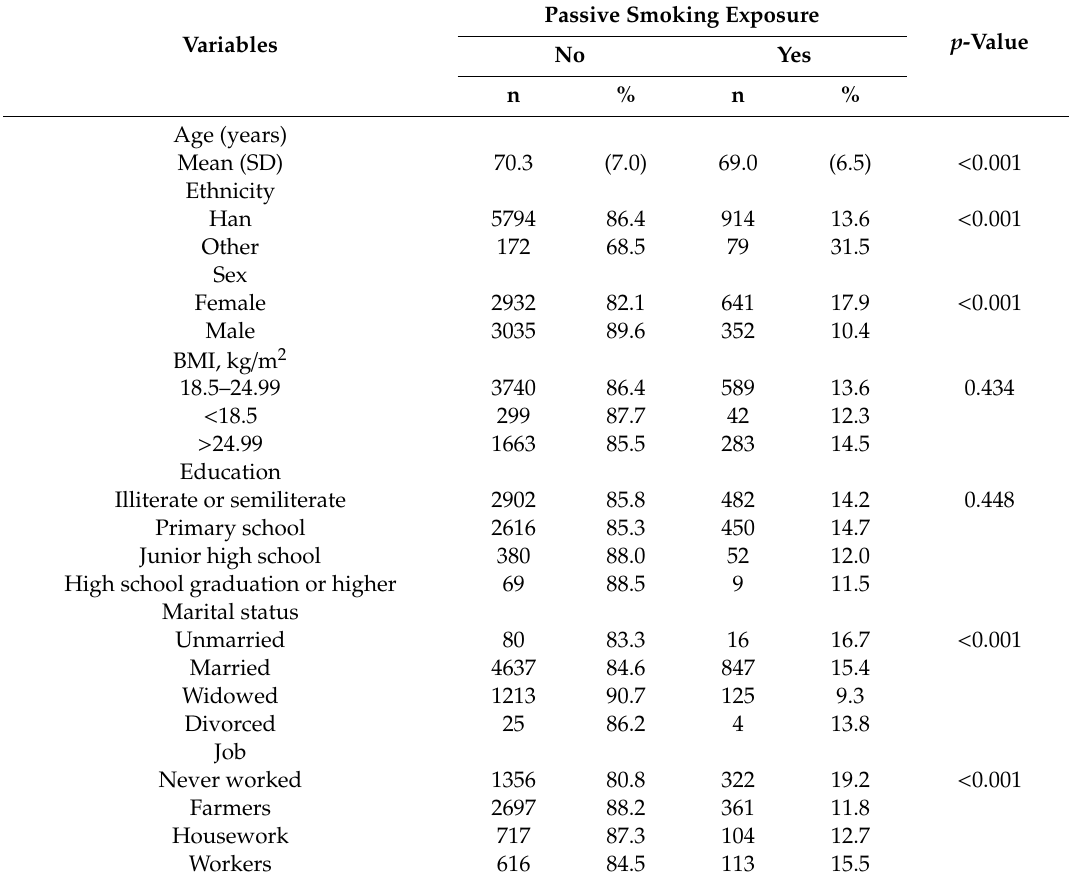
Table 1. Participant’s characteristics according to passive smoking status (ZJMPHS Program, Zhejiang, China).